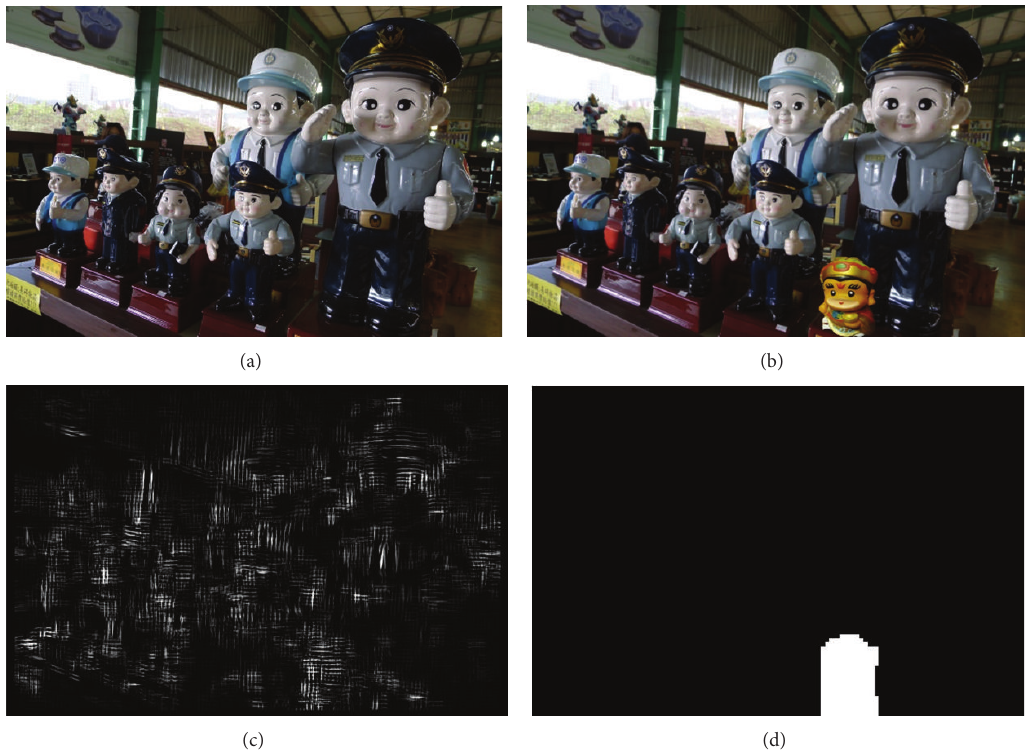
Figure 11: Comparison between the proposed method and Li’s algorithm: (a)intact image; (b) picture with splicing forgery; (c) detection result of Li’s algorithm; and (d) result of our method.